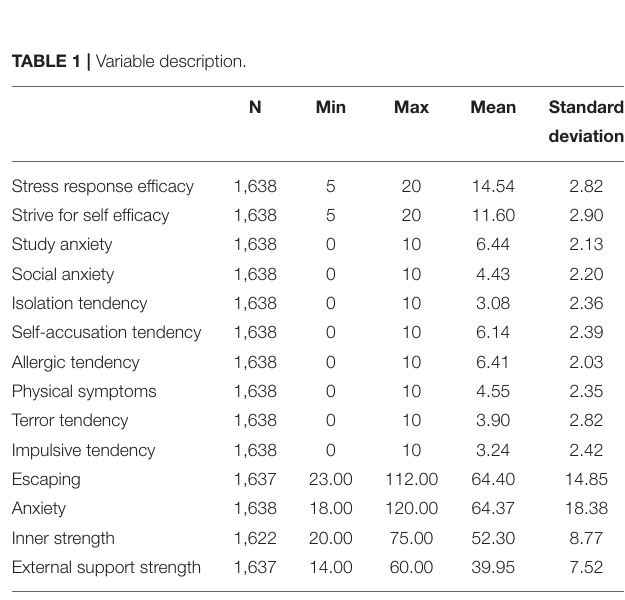
FIGURE 1 | Research ideas of the mental health of children in plight based on deep learning.